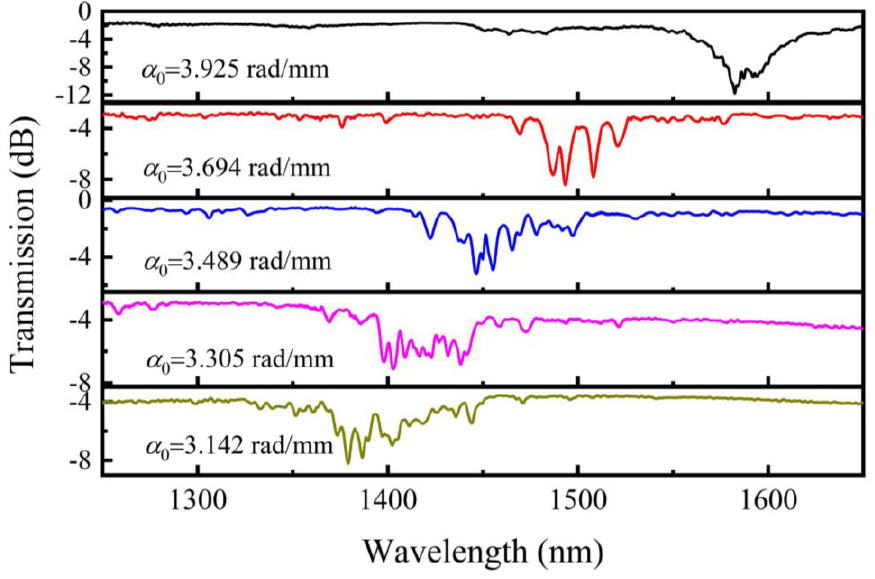
Figure 6. Transmission spectra of LFTPCFs with α 0 varying from 3.142 to 3.925 rad/mm.